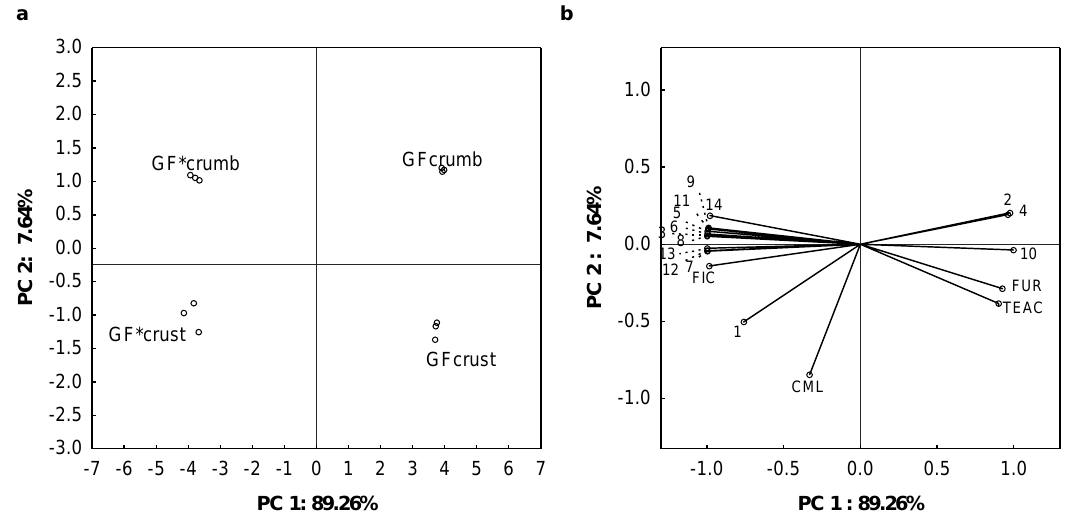
Figure 1. Principal component analysis (PCA) score plot ( a ): gluten-free (GF) crumb: GF bread crumb formulated with raw buckwheat flour; GF crust: GF bread crust formulated with raw buckwheat flour; GF*crumb: GF bread crumb formulated with roasted buckwheat flour; GF*crust: GF bread crust formulated with roasted buckwheat flour; loading plot ( b ): 1: 1- O -sinapoyl-beta- D -glucose; 2: 4-hydroxybenzoate- O -glucoside; 3: 4-hydroxybenzoic acid; 4: caffeic acid; 5: catechin, 6: dihydroxybenzoic acid; 7: ferulic acid; 8: gallic acid; 9: naringenin; 10: quercetin; 11: rutin; 12: syringic acid; 13: vanillic acid; 14: p -coumaric acid.